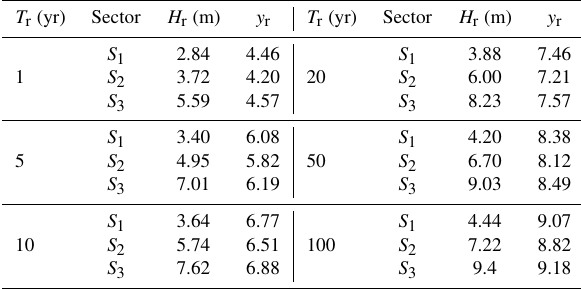
Table 1. Design waves, in terms of H r associated with different return periods ( T r equal to 1, 5, 10, 20, 50 and 100 years), obtained from the La Spezia buoy (1989–2009) for each directional sector ( S 1 , S 2 and S 3 ). T r